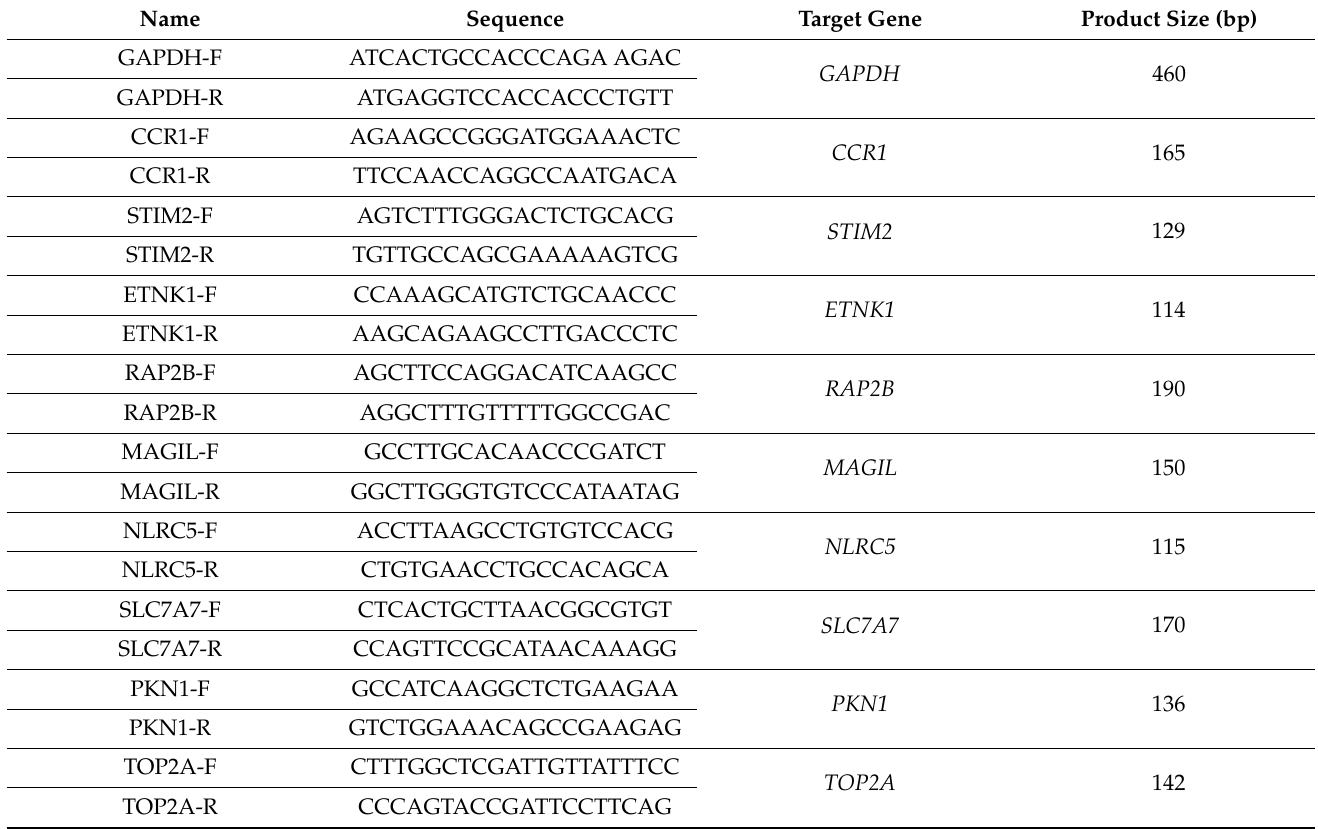
Table 1. Primer name, sequence, target gene and product size used in the present